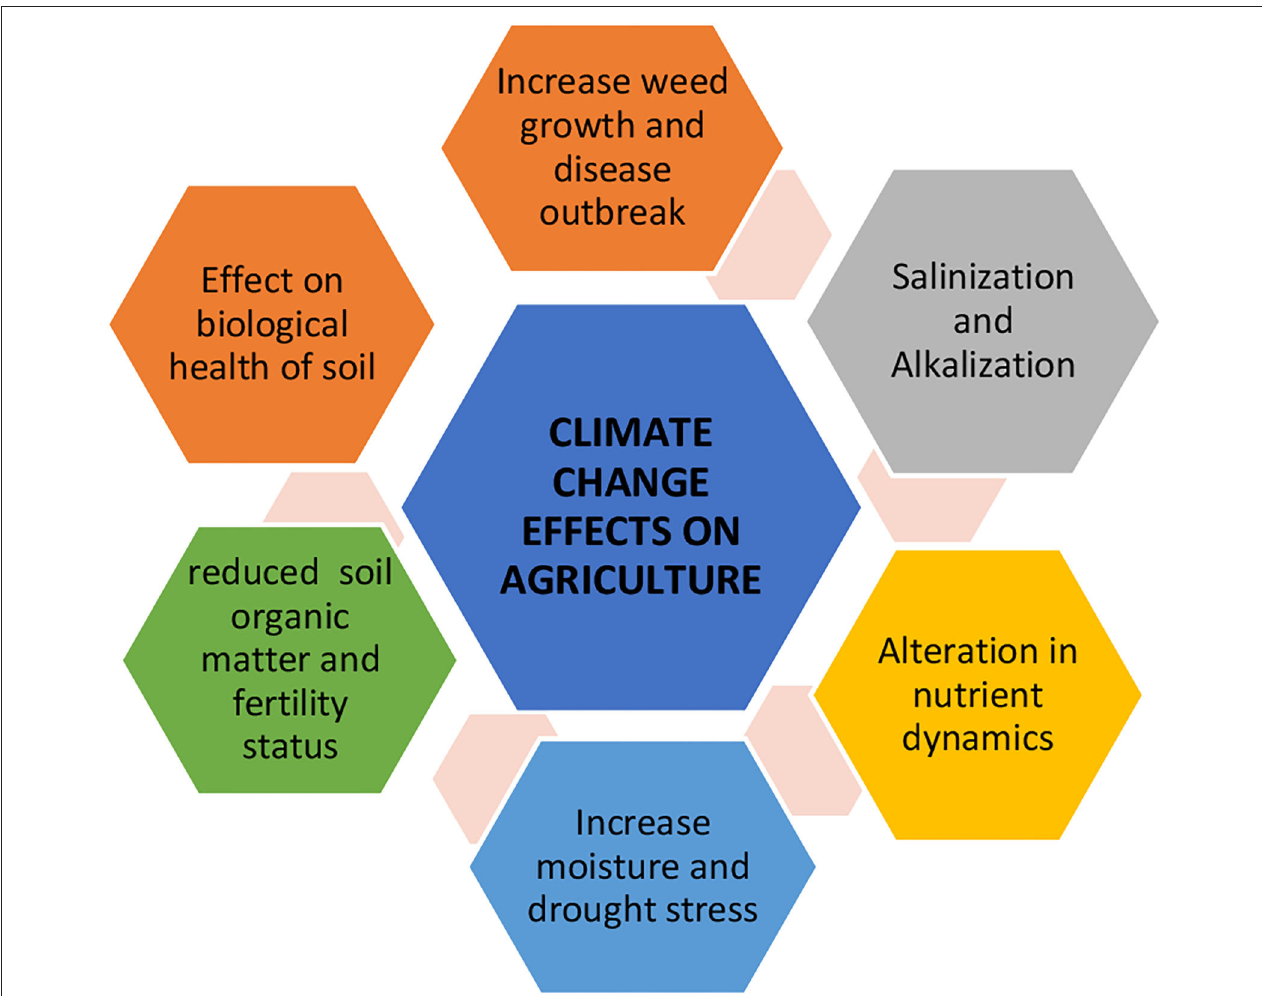
FIGURE 1 | Impact of climate change on